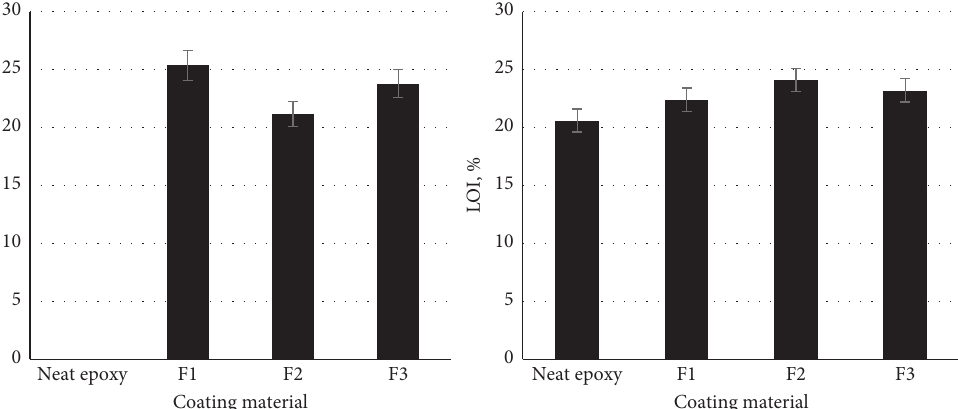
Figure 4: Fire retardant properties of the coating material based on epoxy resin with multi-wall carbon